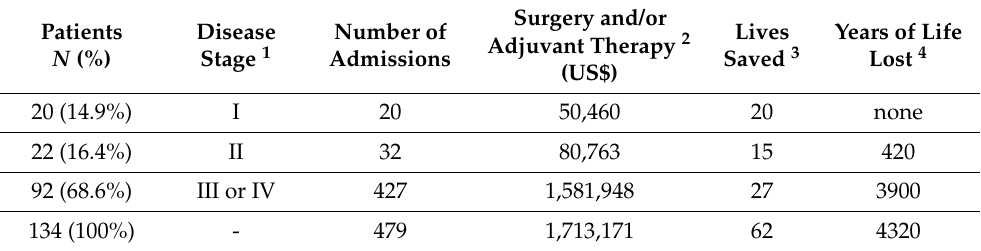
Table 2. DATASUS registry data of children diagnosed with ACT between 2006 and 2019 admitted to public hospitals in Parana